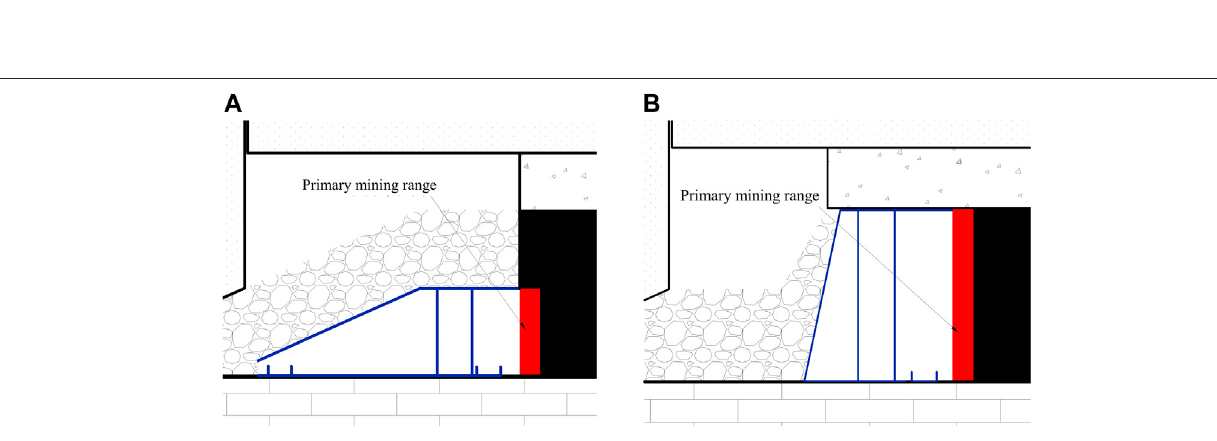
Frontiers in Earth Science |